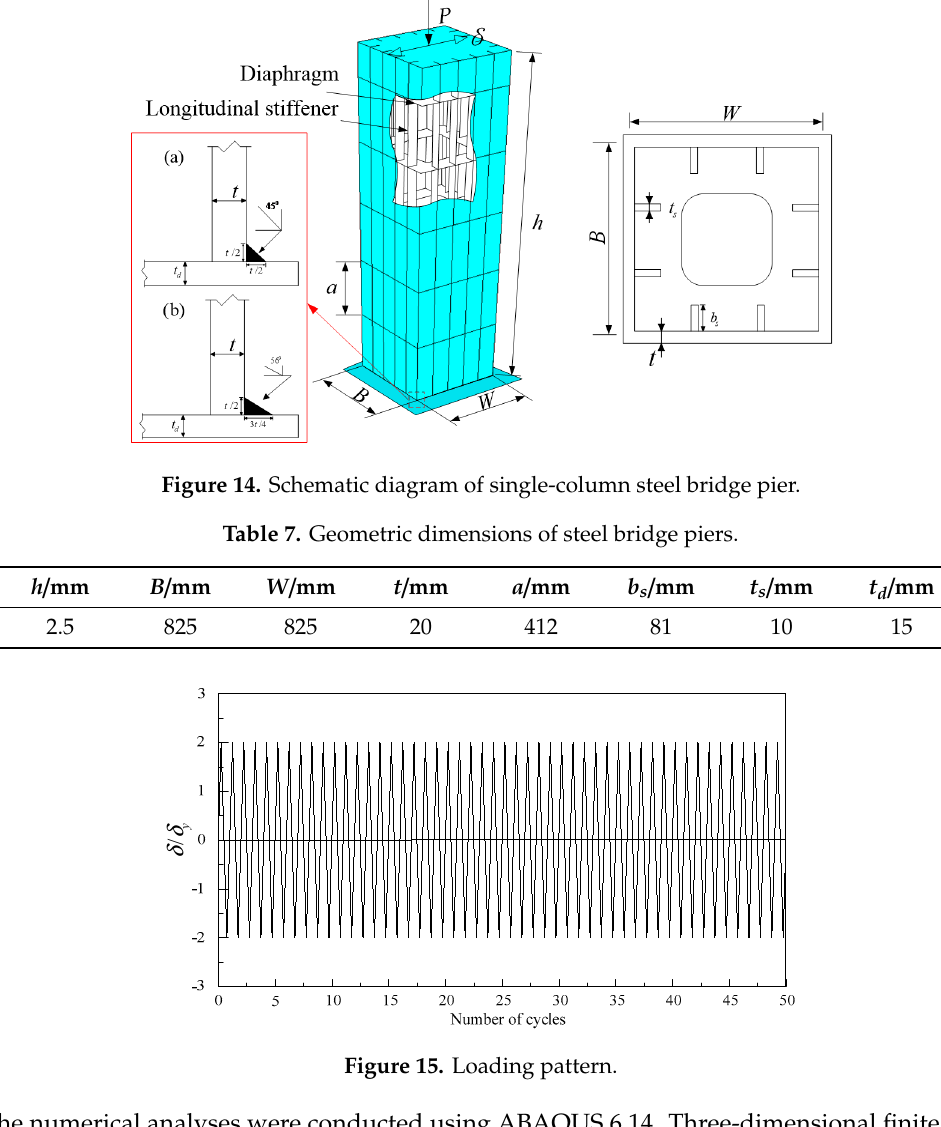
Table 7. Geometric dimensions of steel bridge piers.